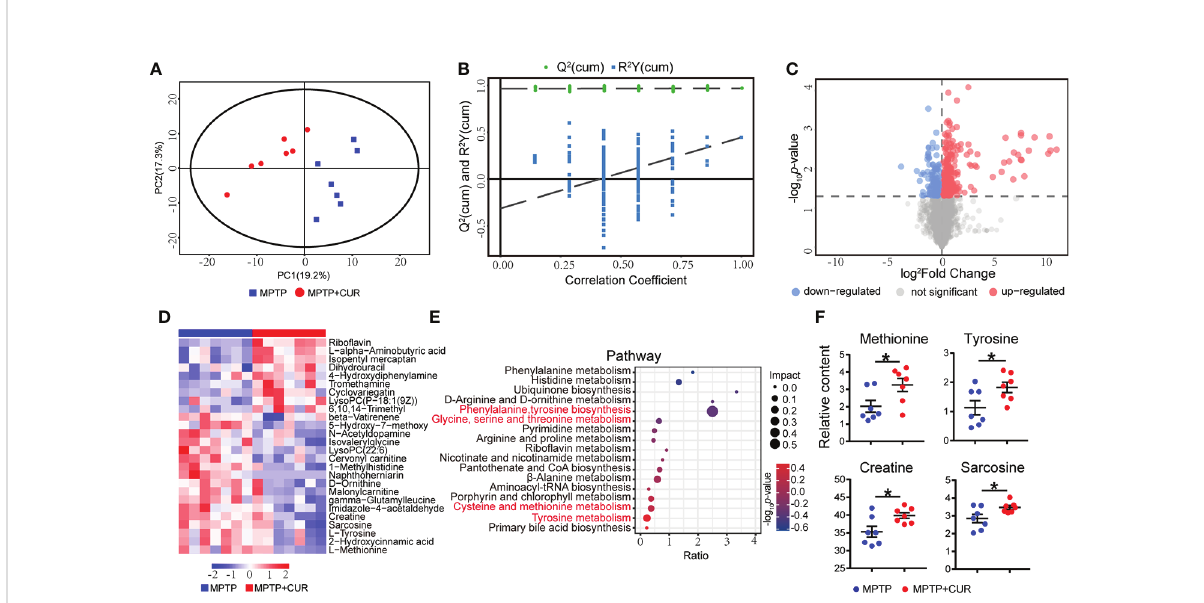
FIGURE 5 CUR administration changes pro fi les of the circulating metabolites in MPTP-induced PD mice model. Male C57BL/6 mice were received intragastric administration of CUR (100 mg/kg) once a day for 4 weeks. On day 15, mice were treated with 200 m L saline containing MPTP (30 mg/kg) or 200 m L saline via intraperitoneal injection every day for a total of 5 times to establish PD mice model. On day 28, serum was collected from the mice to detect the metabolism by using UHPLC-MS (n = 7). (A) The PCoA plot of serum metabonomic between MPTP group and CUR group. (B) OPLA-DA analysis of the serum metabonomic between MPTP group and CUR group. (C) The differentially expressed metabolites between MPTP group and CUR group using a volcano map. ( VIP value > 1 and p value < 0.05). Each dot represents a detected metabolite. (D) Relative contents of differentially expressed metabolites between MPTP and CUR group using a heat map. (E) Comparison of KEGG pathway between the MPTP and CUR group using a bobble plot. (F) Relative contents of tyrosine, methionine, sarcosine, creatine between MPTP and CUR group. Data are expressed as mean ± SEM. Statistical differences were tested using unpaired two-tailed Student ’ s t test in (F) * p <